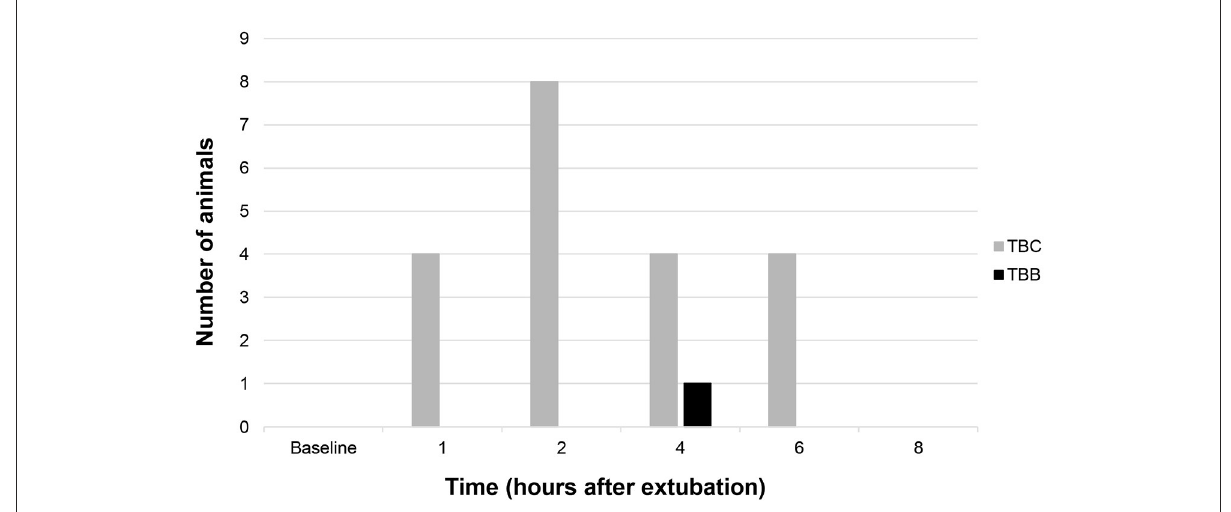
FIGURE3 Number of animals rescued with morphine in both groups in the post-operative period.